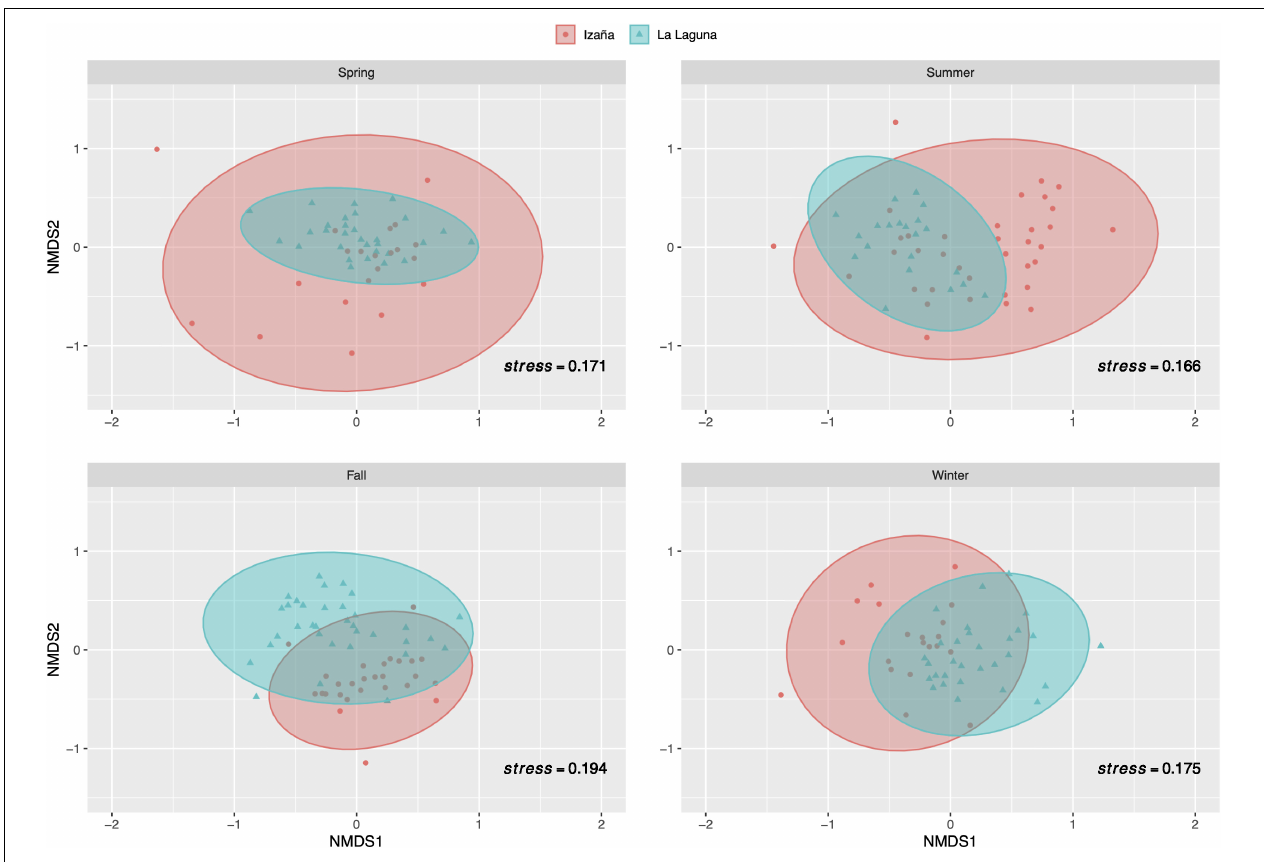
FIGURE 6 | Non-metric multidimensional scaling (NMDS) analysis by season and sampling site. Operational taxonomic units (OTUs) that did not appear more than five times in more than half of the samples were removed. Five most predominant phyla were selected for the analysis. Stress value under 0.2 denotes good ordination of microbial community samples in two